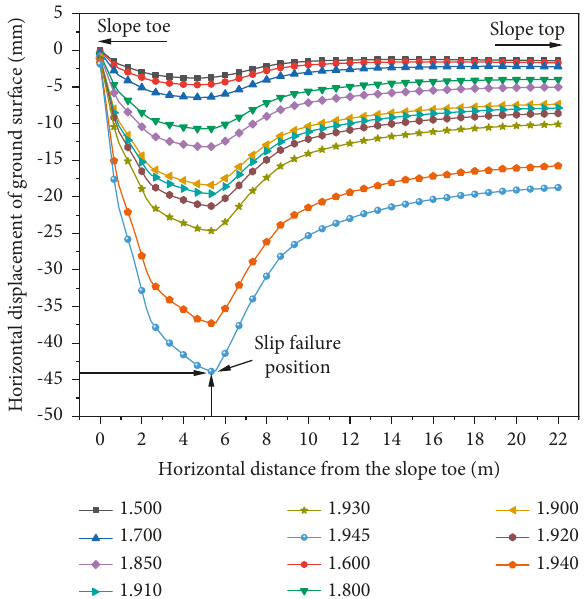
Figure 13: Distribution law of the horizontal displacement of the tunnel surface.